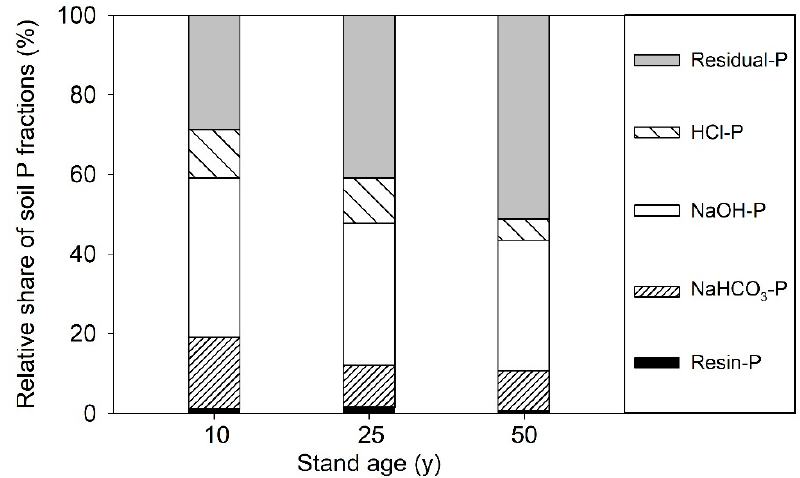
Figure 2. Distribution of soil P fractions for different stand ages on larch plantations. NaHCO 3 -P is the